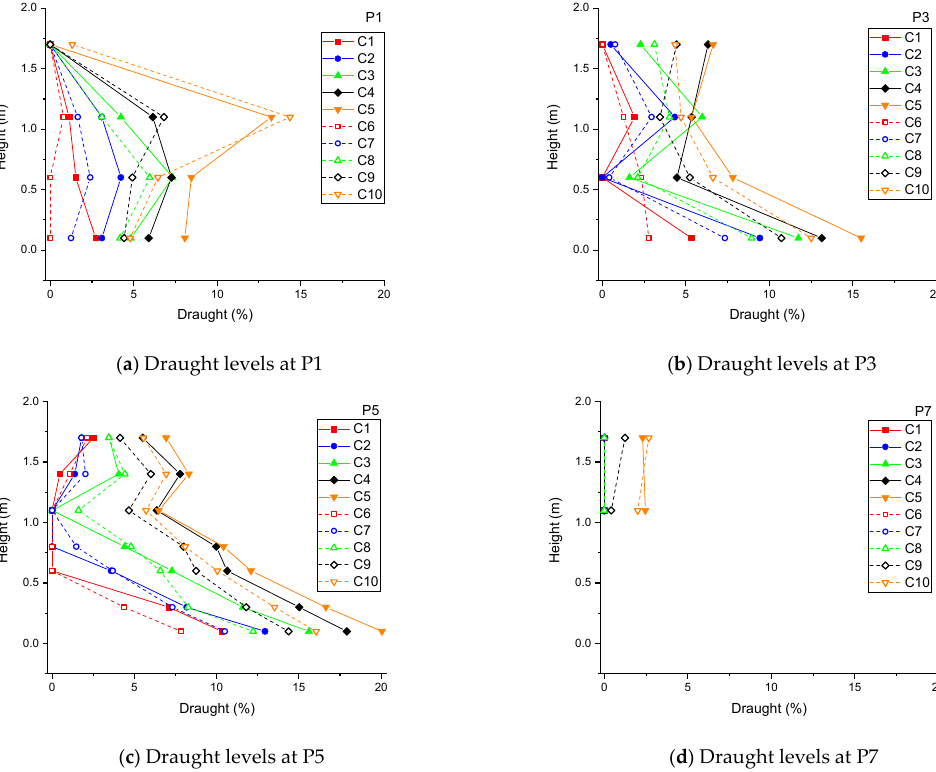
Figure 8. Draught levels at position P1 ( a ), P3 ( b ), P5 ( c ) and P7 ( d ) for cooling cases (C1–C10).